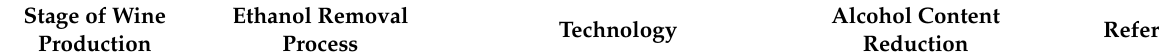
Table 1. Different techniques to reduce wine alcohol content in the several stages of wine